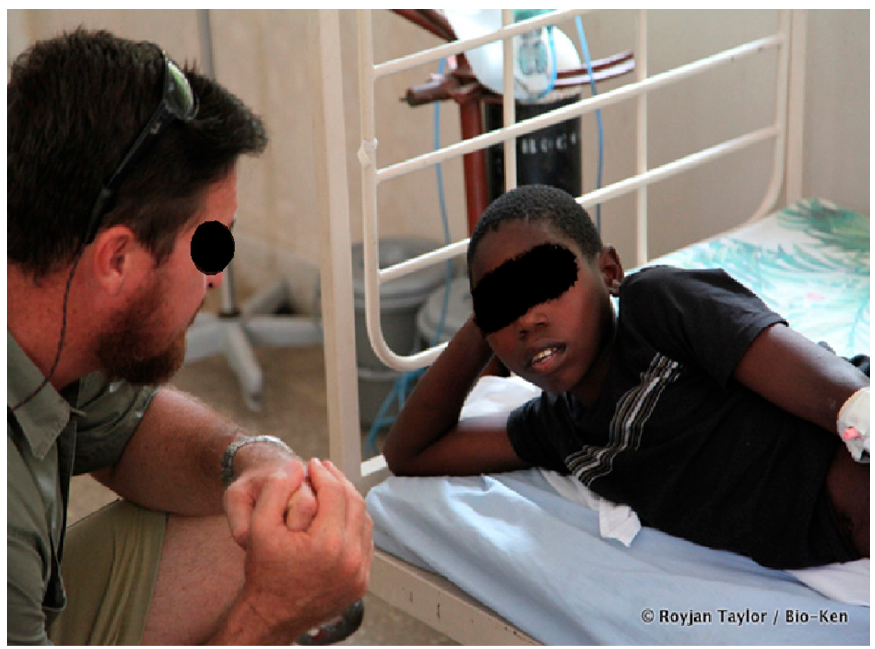
Figure 4. Victim of the black mamba bite (on the right) after reversal of envenomation.